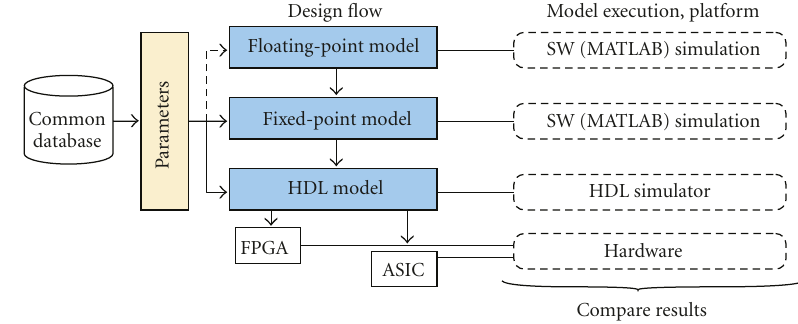
Figure 2: Design representations for the VLSI development